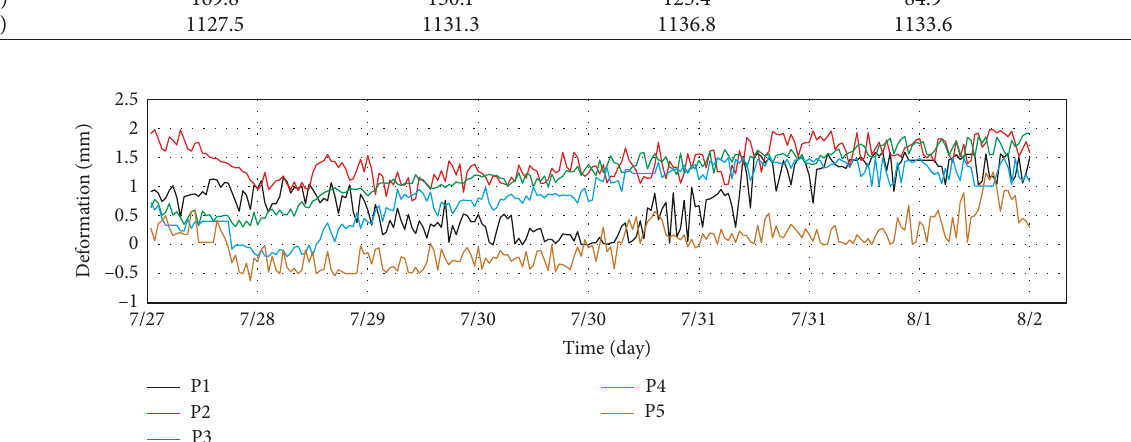
Table 3: Coordinates of the five points at the top of the dam in the image coordinate system. Point